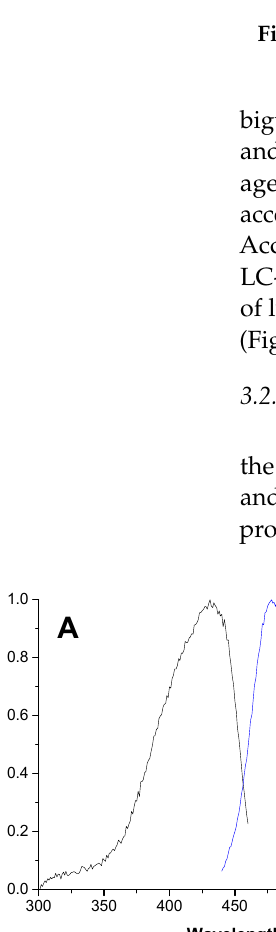
Figure 2. On-resin ( A ) and in-solution ( B ) enzymatic cleavage.